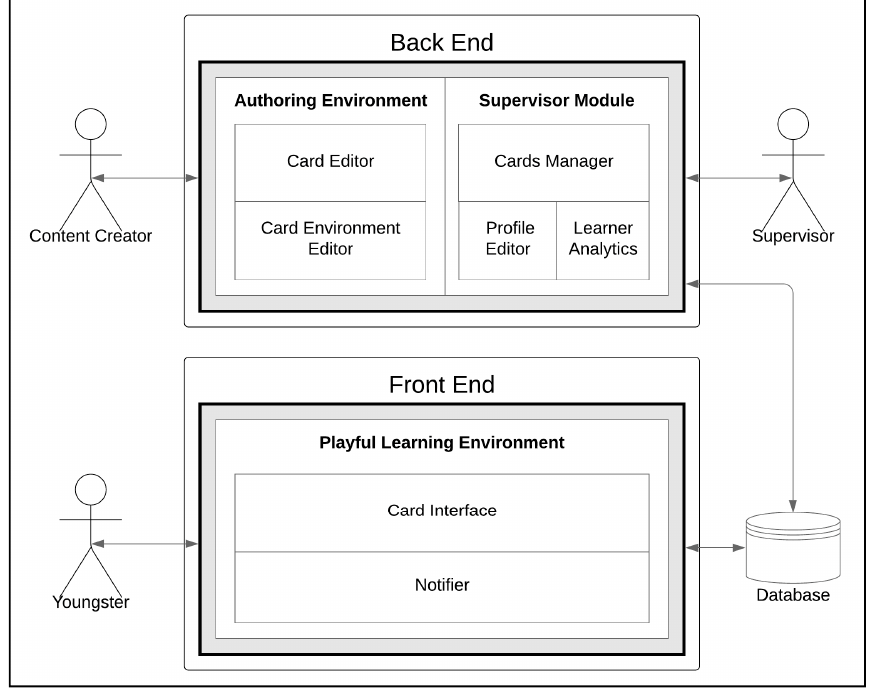
Figure 1. Architecture of TICKLE.